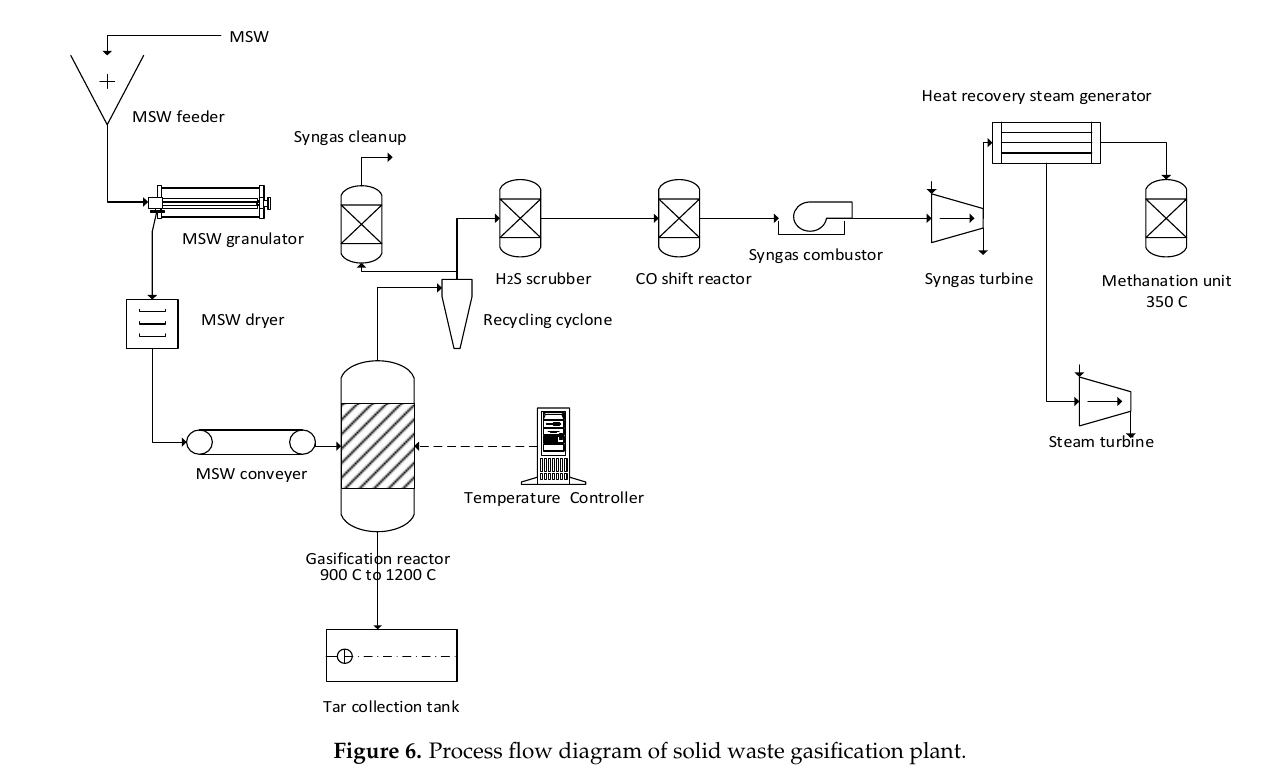
Figure 6. Process flow diagram of solid waste gasification plant.